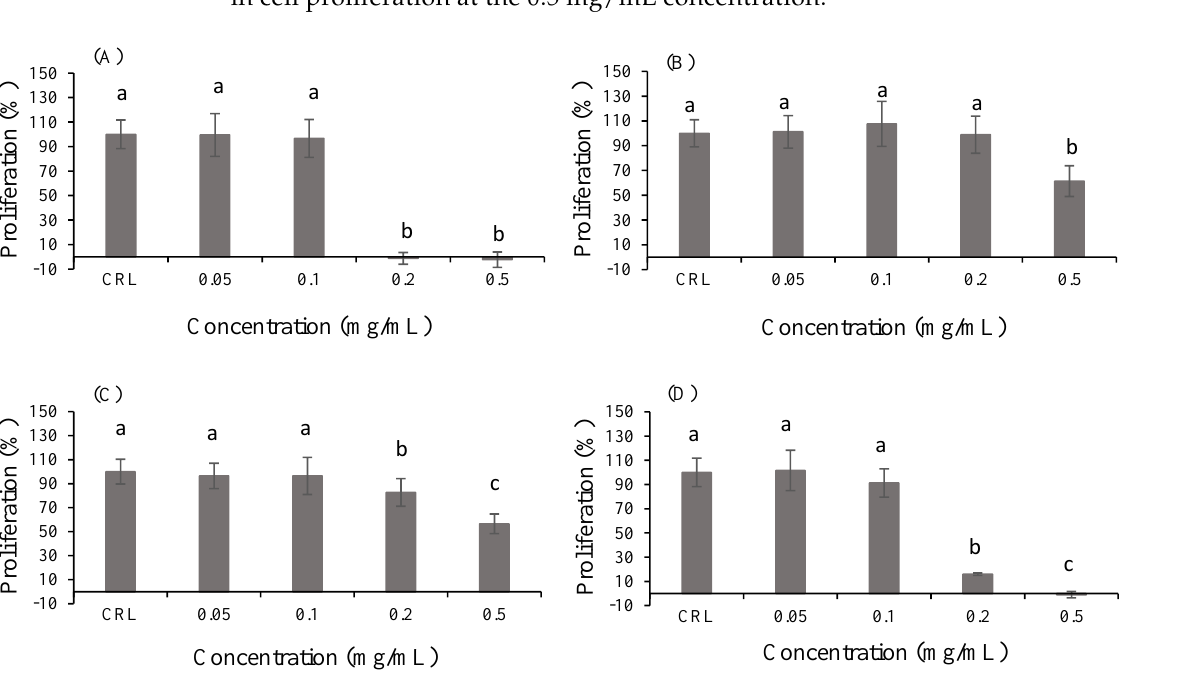
Figure 1. Effect of bioaccessible fractions of product 1 ( A ), product 2 ( B ), product 3 ( C ) and collagen ( D ) on cell proliferation in Caco-2 cells after 24 h of exposure at increasing concentrations from 0.05 to 0.5 mg/mL as assessed by the MTT assay. Values are expressed as mean ± SEM ( n = 3). Values in the same figure with different superscript letters are significantly different ( p < 0.05). CRL: control.